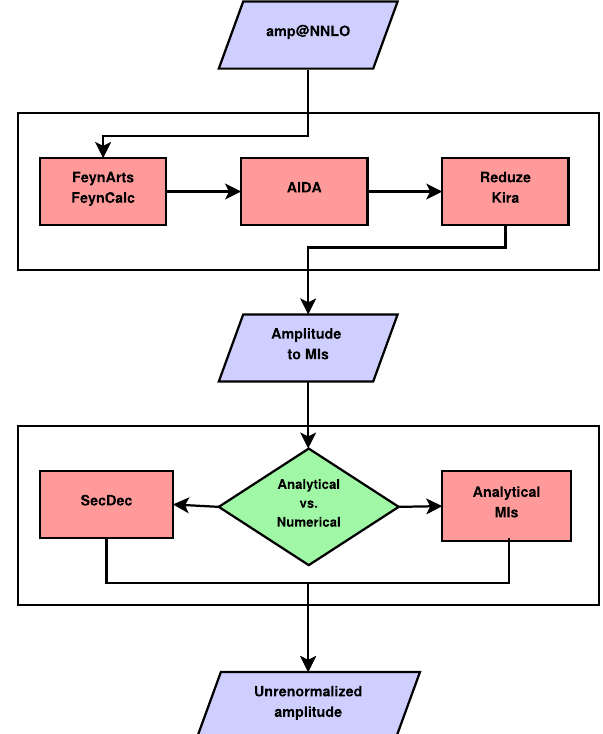
Fig. 8 Flowchart of the algorithm to evaluate the two-loop